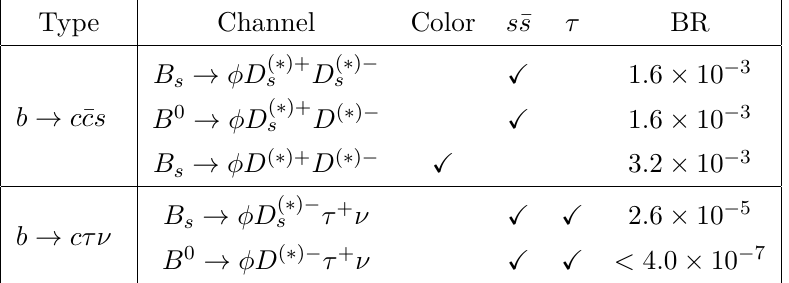
Table 6 . Major backgrounds for the B s → φτ + τ − measurement. “Color”, “ s ¯ s ” and “ τ ” represent the three effects suppressing the B -meson decays which are discussed in the